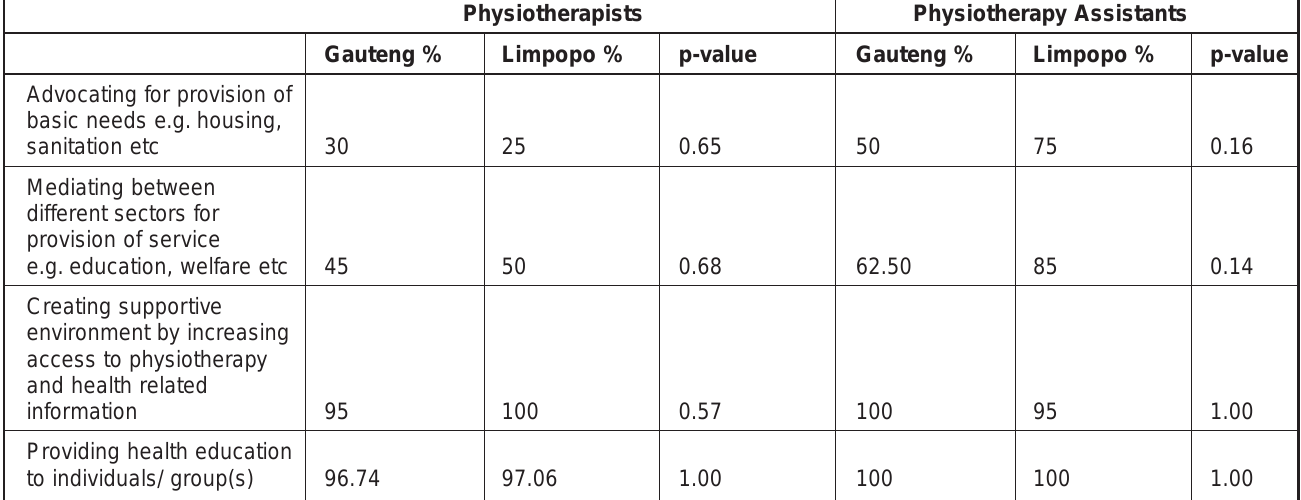
Table 2: Work Experience in PHC for Physiotherapists and